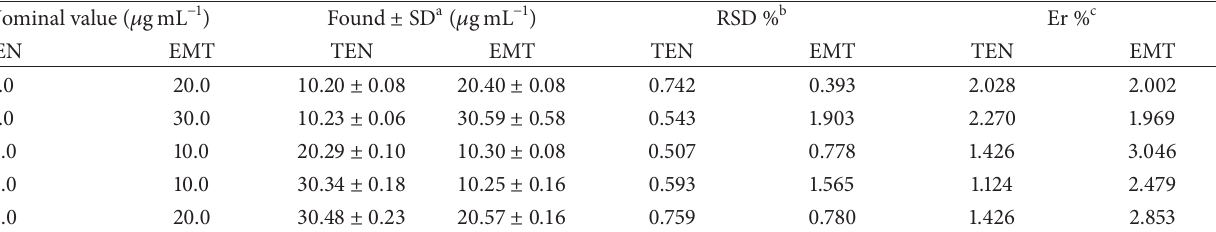
Table 3: Determination of TEN and EMT in laboratory-prepared mixtures using the proposed spectrophotometric methods.